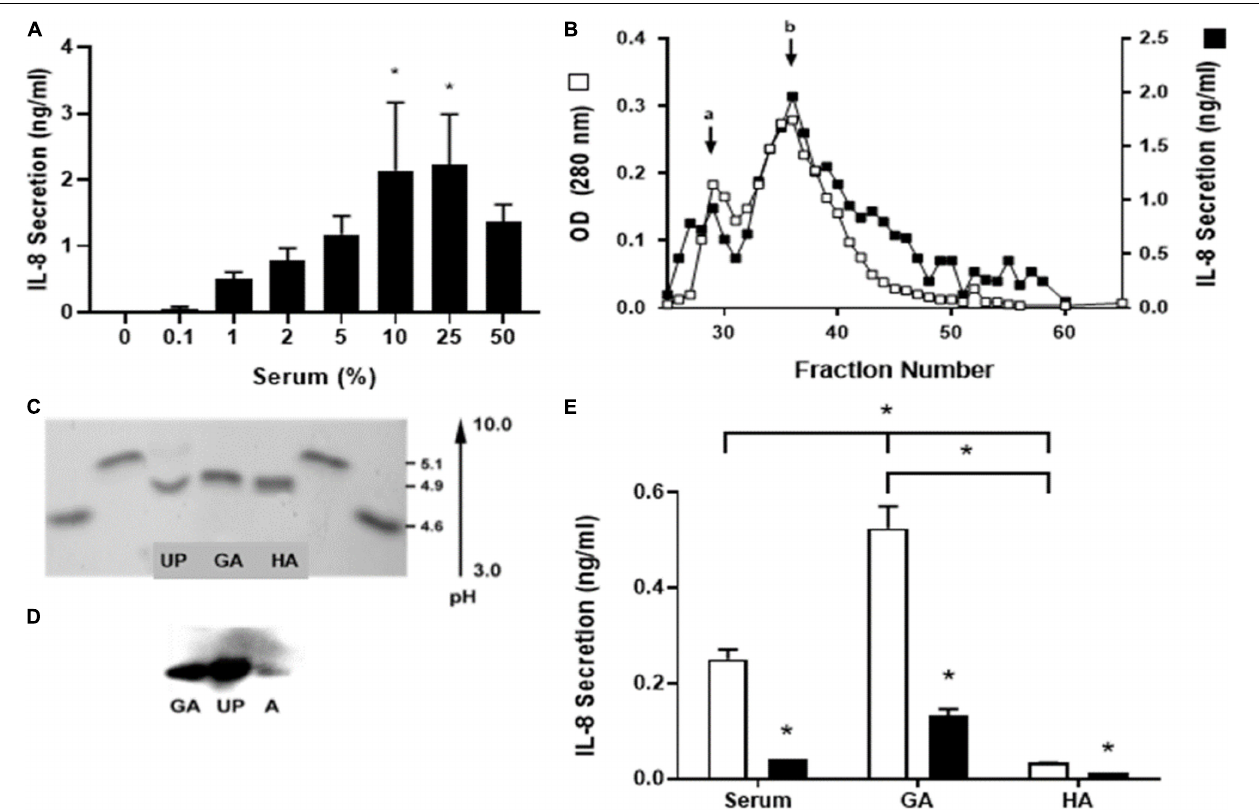
FIGURE 1 | Identification of the serum component responsible for stimulation of IL-8 secretion. Human single-dose serum induced IL-8 secretion in a dose-dependent manner. (A) Nasal epithelial cells were incubated for 5 h with a different percentage of human single-dose serum, and IL-8 secretion was measured. Serum induced a dose-dependent IL-8 secretion with a maximum at 25%. * Indicates a statistically significant increase ( p < 0.05) in IL-8 compared to control. (B) Different serum fractions obtained from an S-200 Sephacryl gel column were assayed for IL-8 secretion, and the optical densities at 280 nm were compared. Two peaks were obtained (a and b); the major peak (b) seems to be a dimmer of the active protein. These peptides from a trypsin digest of the peak protein were analyzed by MS and used in a BLAST search of human proteins to identify the unknown protein (UP). (C) UP was isoelectric focused with glycated albumin (GA) and human albumin (HA) to determine their isoelectric point (pI). Two standards used soybean trypsin inhibitor (4.6 pI) and bovine β -lactoglobulin A (5.1 pI) loaded at both sides from the bands of interest. UP has the same pI as GA and HA. (D) A Western blot with anti-glycated albumin antibody was carried out. GA, UP, and HA were recognized with the same molecular weight. (E) IL-8 secretion induced by serum and glycated albumin (GA) in CF1-16 cells was reduced with an anti-human GA antibody. The CF epithelial cell line was incubated for 5 h with commercial pooled human serum (serum), GA (2 mg/mL), or albumin (HA, 2 mg/mL) and an anti-human GA antibody (black bar). Open bars have no antibody. Serum and GA increased IL-8 secretion, which was blocked when cells were coincubated with the GA antibody. * Indicates a statistically significant ( p < 0.05) reduction in IL-8 secretion in the presence of the antibody in all groups (open vs. black bar) or higher IL-8 secretion in cell cultures incubated with GA compared to serum or HA and serum compared to HA. n = 3 for experiments included in (A,E) . Experiments for (B–D) were repeated three